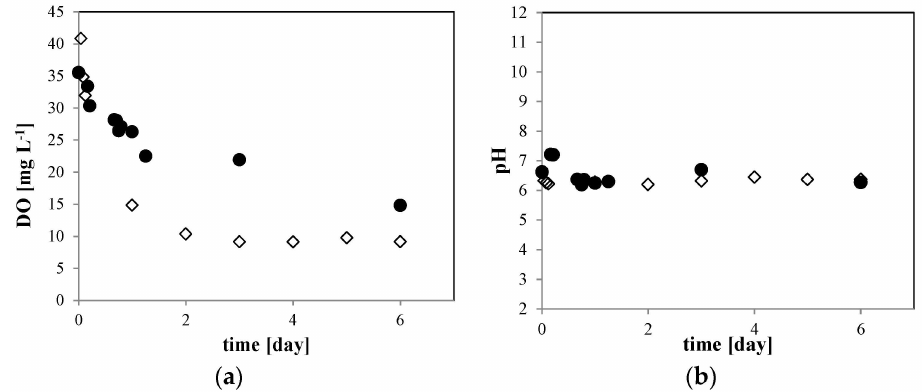
Figure 6. Time dependence of ( a ) DO concentration and ( b ) pH of the O 2 MNB in the solution including 0 mM (open diamond) and 10 mM NaCl (solid circle). The measurement uncertainties are within the size of each